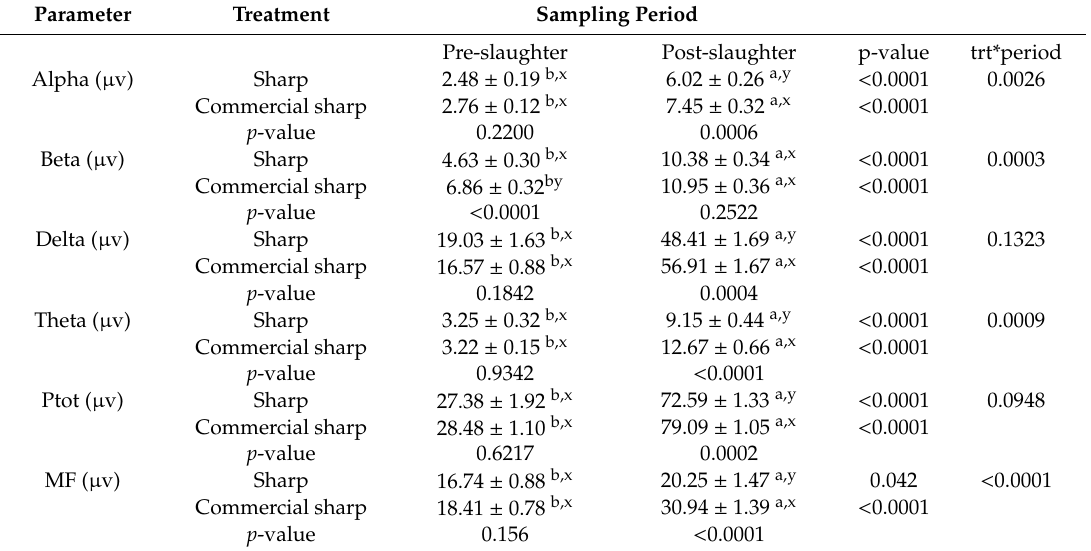
Table 4. Electroencephalographic changes in cattle subjected to di ff erent knife sharpness at pre- and